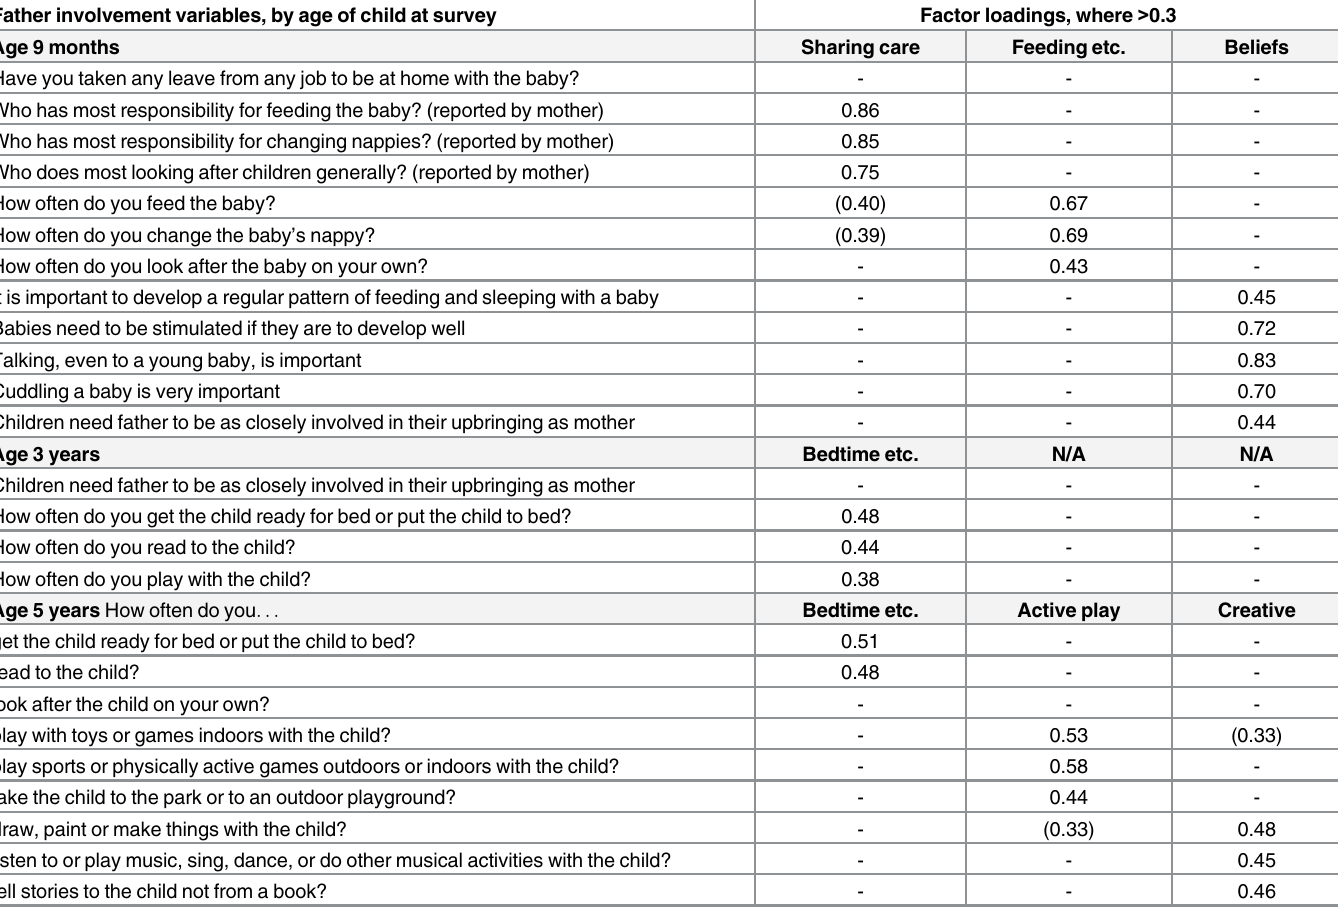
Table 1. Father involvement variables: rotated loadings from exploratory factor